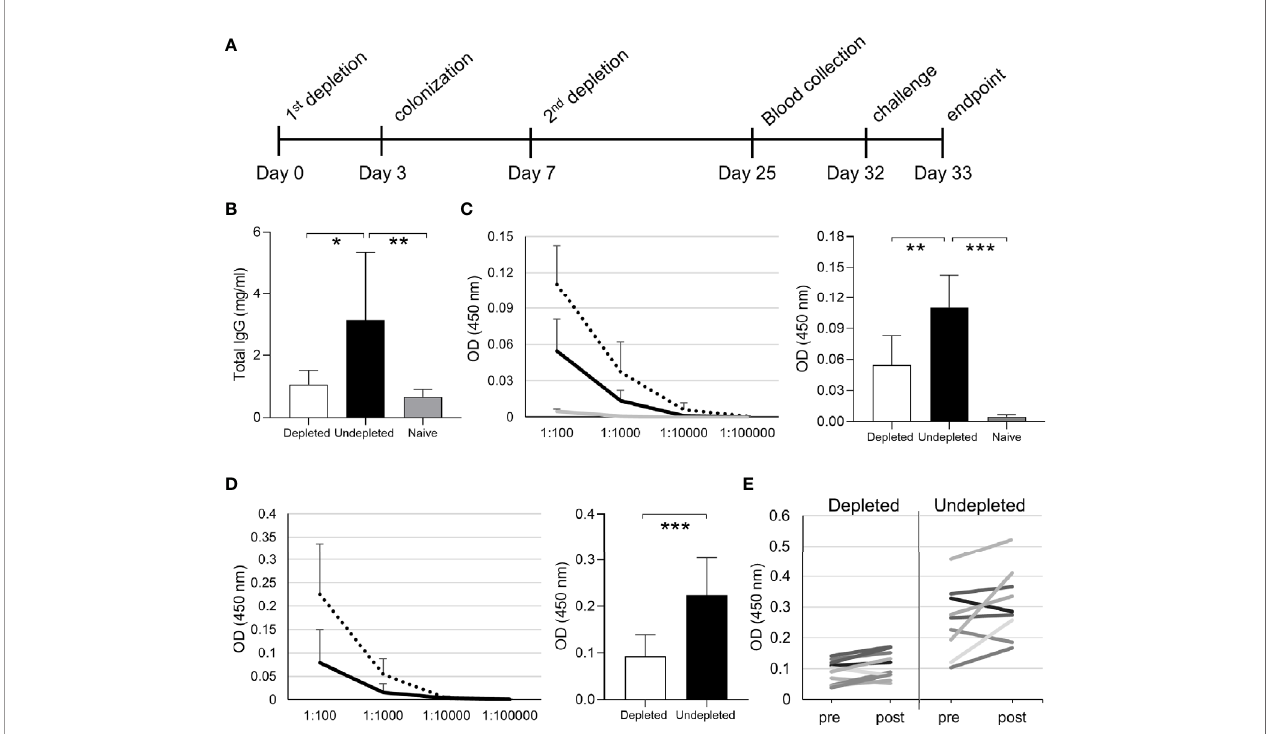
FIGURE 4 | Antibody response in depleted/colonized mice. (A) The full timeline of B cell depletion treatment with aCD20 antibody followed by intranasal pneumococcal colonization is reported. (B) Total IgG levels of the depleted colonized and not depleted colonized groups. IgG speci fi c to 6B (C) and TIGR4 (D) pneumococcal strains measured by whole cell ELISA assay are reported both for serially diluted sera and at 1:100 dilution. Depleted (solid line) and undepleted (dotted line) mice IgG levels are shown for both strains, uncolonized control IgG levels (gray line) is only shown for 6B. (E) Comparison of anti-pneumococcus IgG levels of individual mouse sera before and after challenge are also reported. Bars represent the average values for each group. Error bars indicate standard deviations and Mann Whitney U test was used for statistical analysis (*P < 0.05, **P < 0.01, ***P <